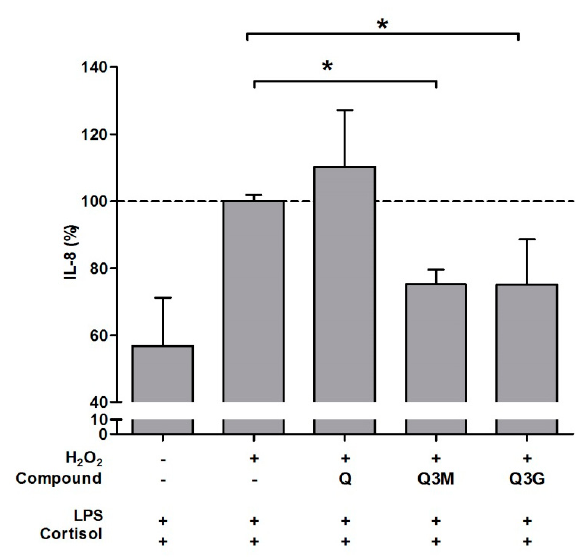
Figure 3. Effect of quercetin (Q) metabolites on cortisol response. Cells were pre-incubated with H 2 O 2 (800 µM) ± Q metabolites (10 µM) for 1 h and subsequently exposed to LPS (10 ng/mL) and cortisol (100 nM) for 16 h and IL-8 levels (%) measured in the cell medium ( N = 6, mean ± SD, * p < 0.05 Mann-Whitney U test). The dotted line represents IL-8 production of cells pre-incubated with H 2 O 2 (800 µM) without the bioactives, and subsequently exposed to LPS (10 ng/mL) and cortisol (100 nM).